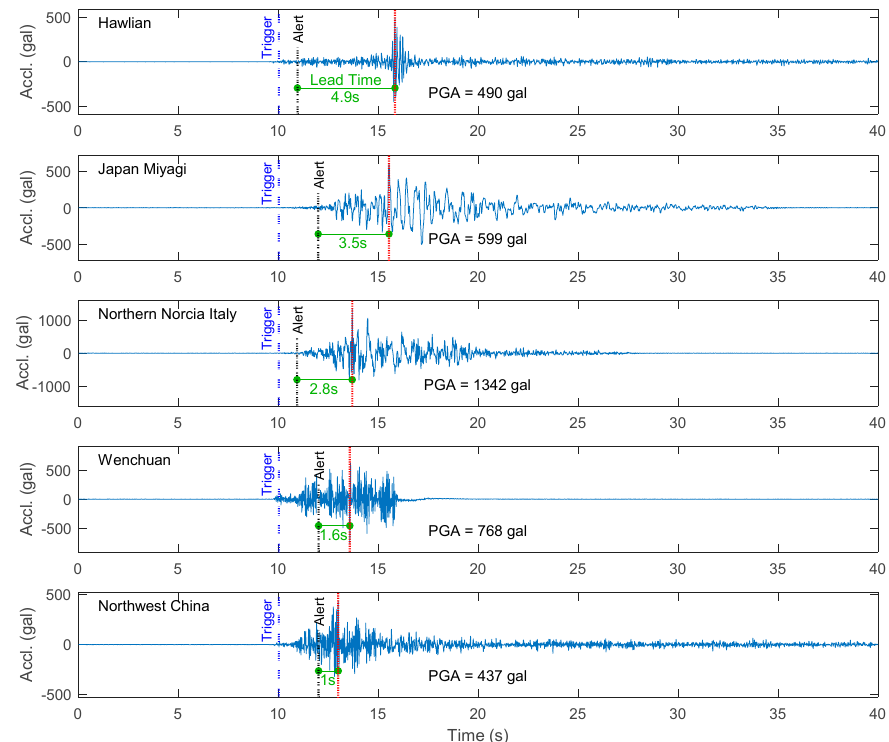
Figure 13. The typical five time histories with the shortest lead time for the worldwide earthquake dataset using the LG Stylus smartphone.